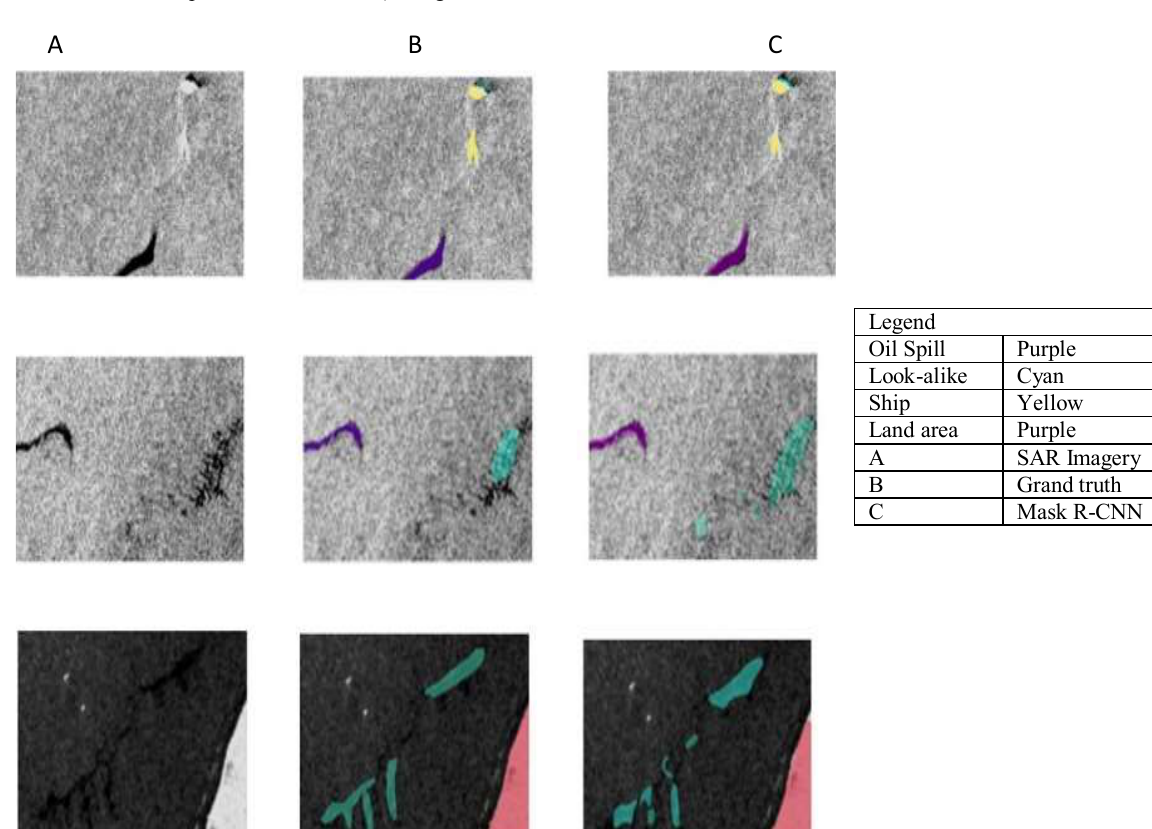
Figure 2 . Examples of Qualitative Output of the Mask R-CNN model, the Ground truth and SAR